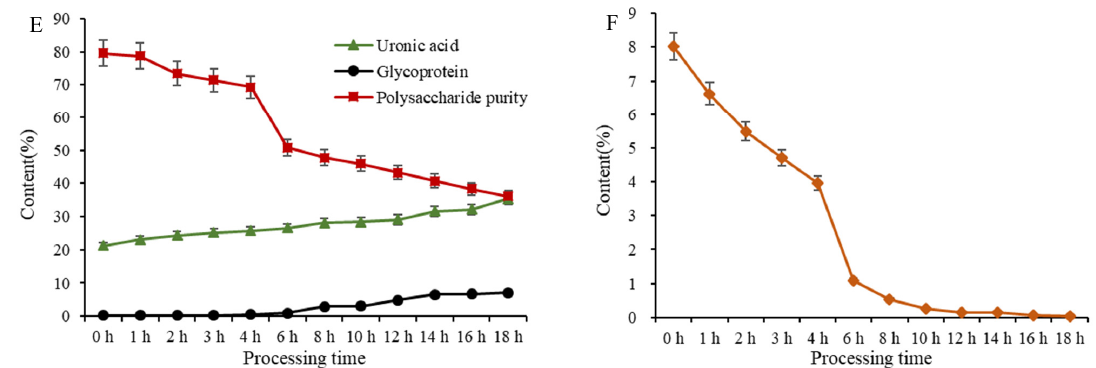
Figure 5. ( A ) Monosaccharide composition of PCP with varying processing times. ( B ) HPGPC-RID chromatograms of PCP with varying processing times. ( C ) The molar ratio of each monosaccharide to all monosaccharides. ( D ) Ratio of each PCP peak area to total PCP peak area. ( E ) Glycoprotein, uronic acid, and total polysaccharide content variations of PCP during processing. ( F ) Polysaccharide content variations of PCR medicinal materials during processing.